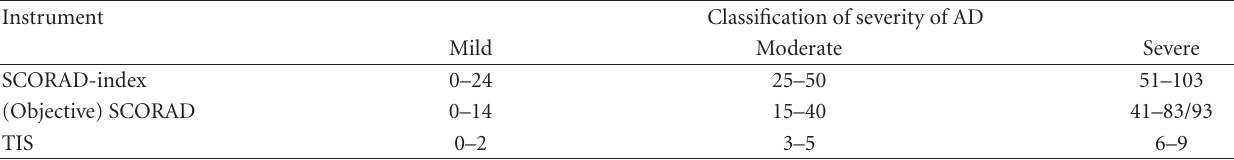
Table 2: Classification of the severity of atopic dermatitis for the SCORAD-index, the (objective) SCORAD, and Three Item Severity score (TIS) ± .